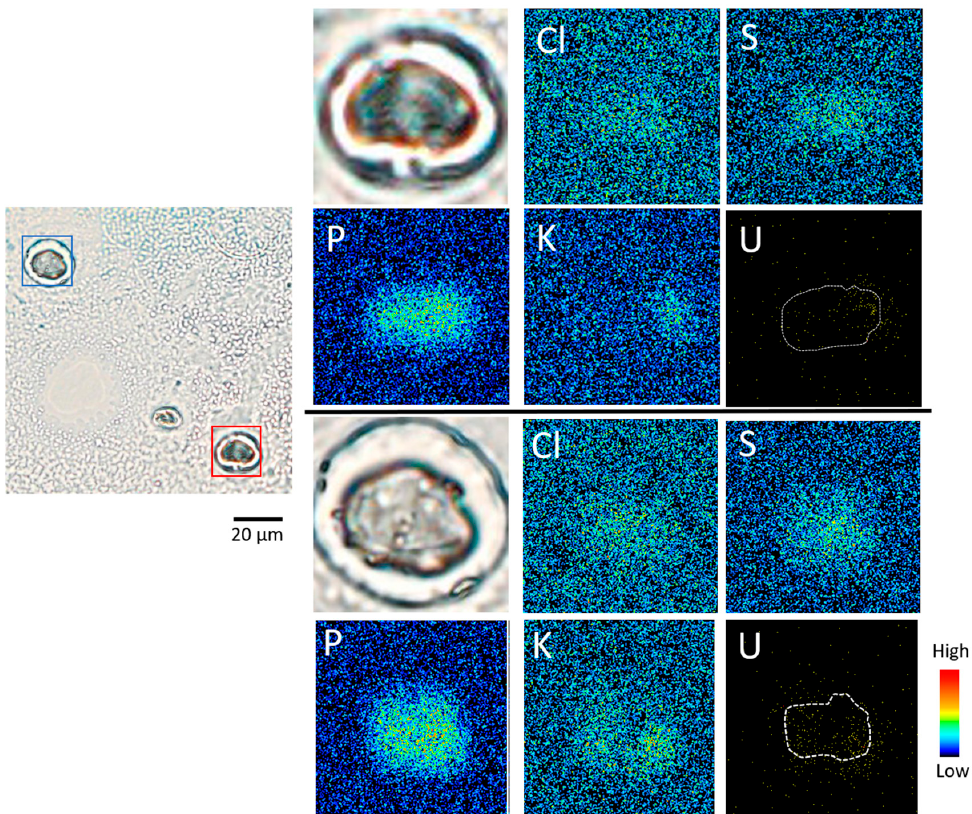
Figure 6. PIXE imaging of cryo-section of uranium-treated S3 cells. (Left panel) Photo of cryosection of S3 cells exposed to uranium for 24 h. Elemental imaging was performed with the following conditions in the boxed areas: scanning area, 20 μ m × 20 μ m, integrated charge, 0.2 μ C, and beam size, 1 μ m ×1 μ m (Upper panel). Elemental images are in the red boxed area (Lower panel). Elemental images are in the blue boxed area. Dashed line corresponds to phosphorus distribution.